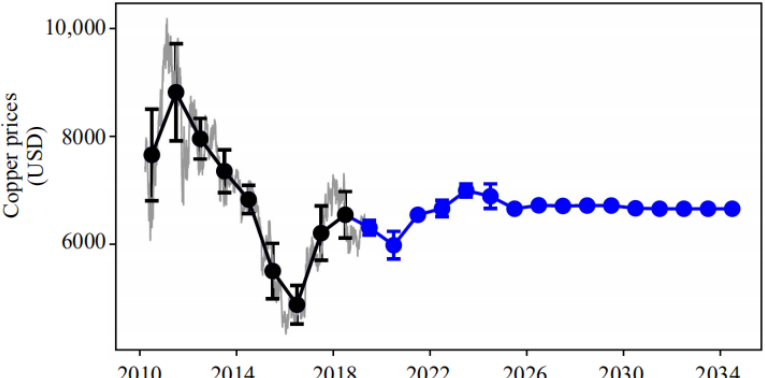
Figure 5. Forecast results of copper price in the next 16 years. The blue curve represents the fore-